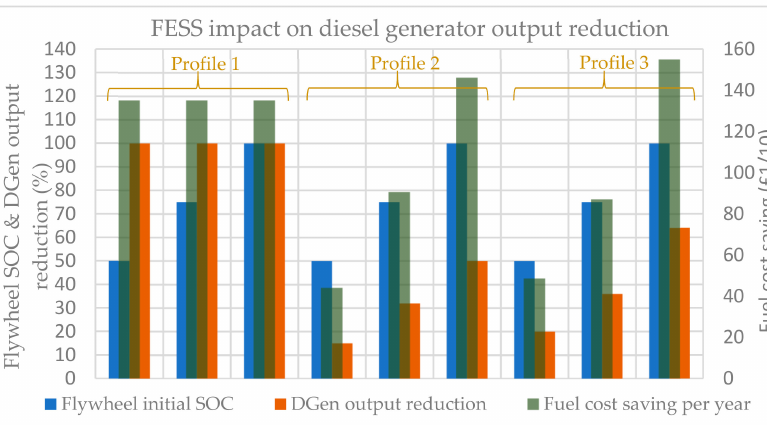
Figure 27. Diesel engine output reduction and cost savings relative to flywheel